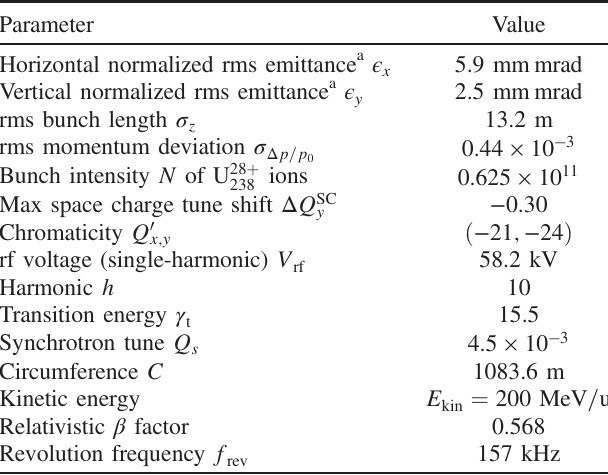
TABLE I. Considered parameters for 238 U 28 þ accumulation at SIS100 injection energy.